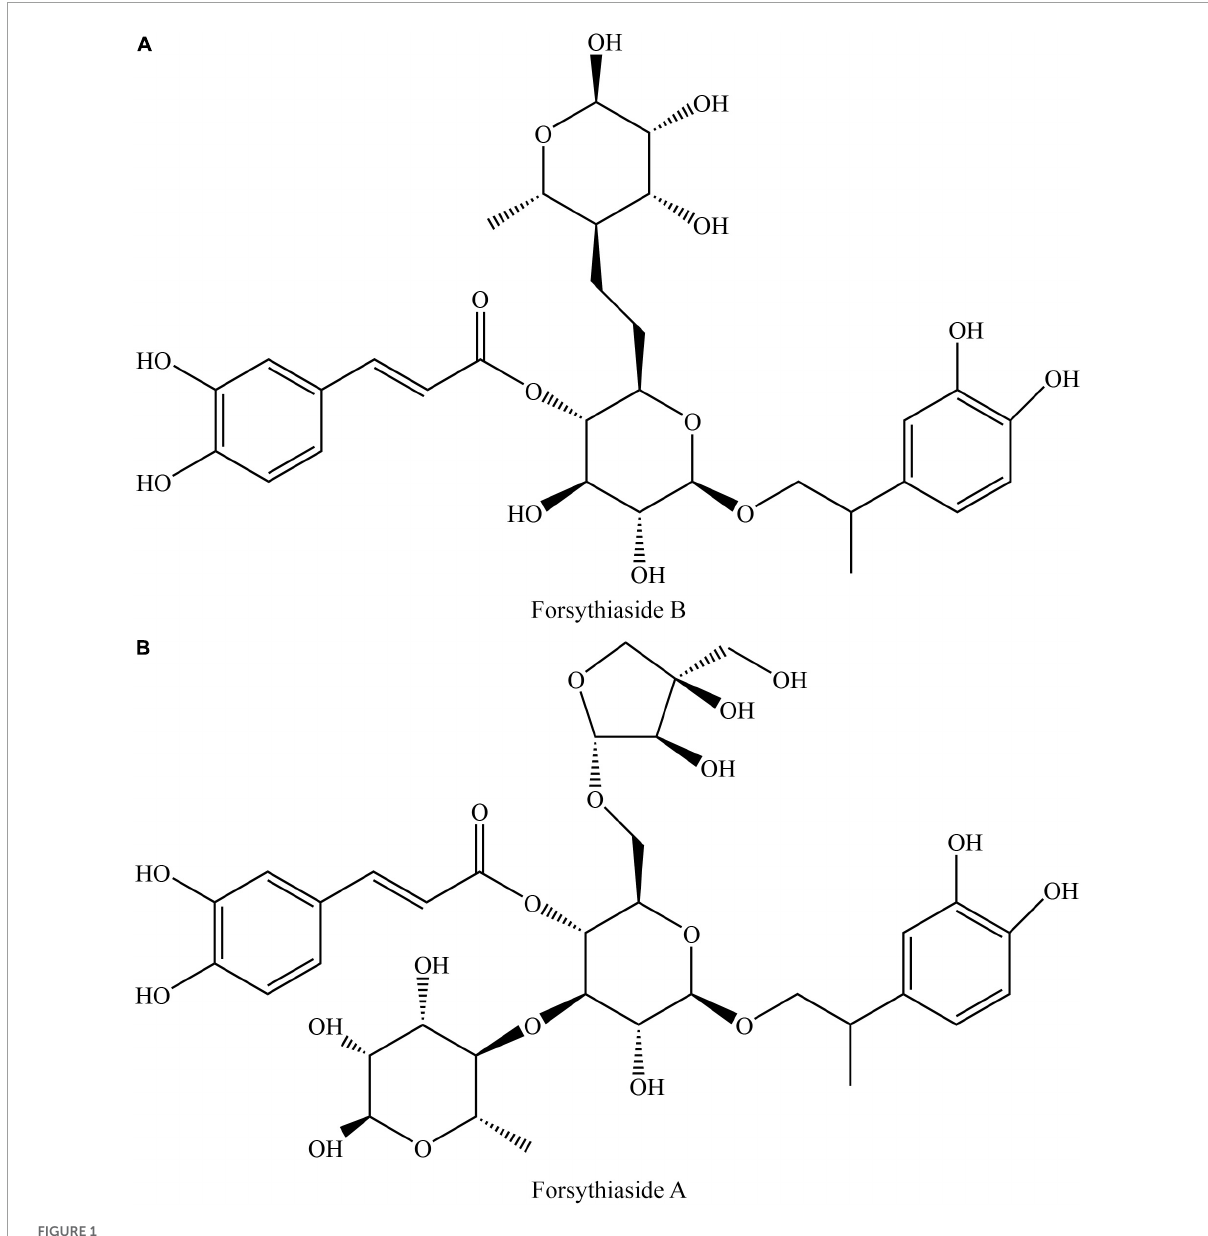
FIGURE1 Structures of forsythiaside A (A) and forsythiaside B (B)